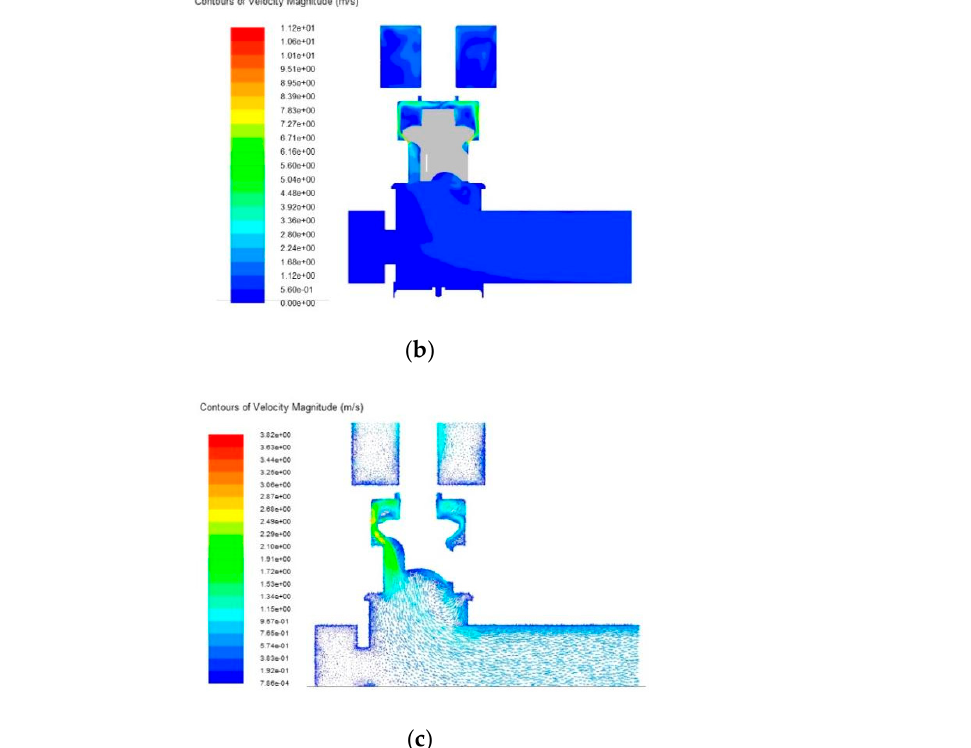
Figure 13. Underground test setup for the newly developed reciprocating pump.